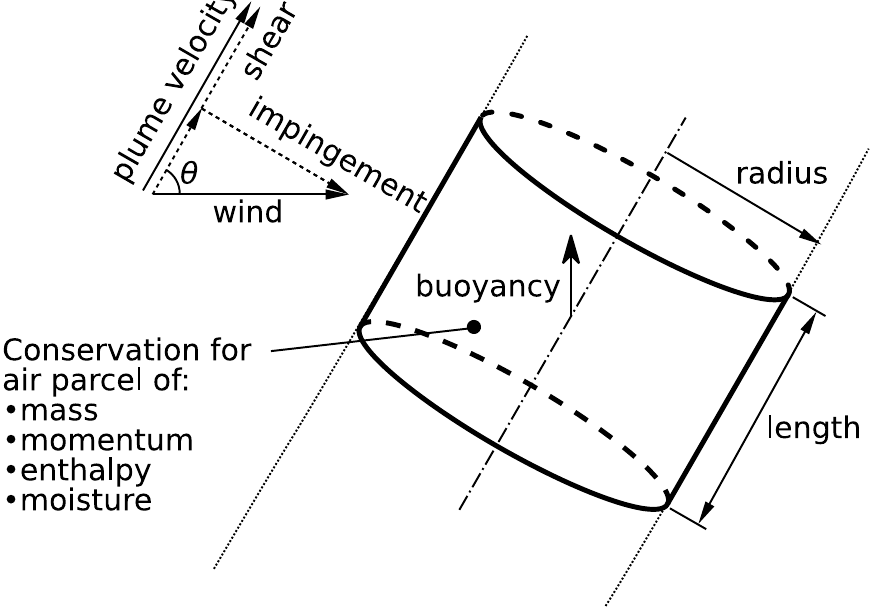
Figure 2. An illustration of an air parcel for which the force balance and air entrainment form the basis of the model.